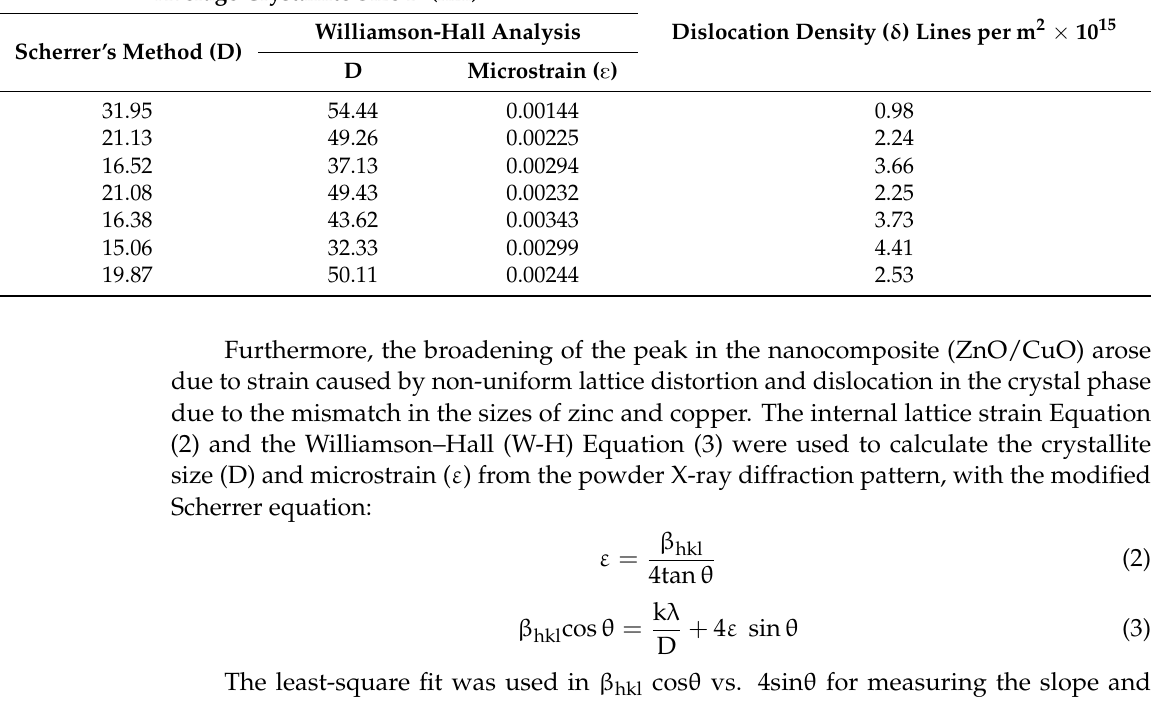
Table 1. Comparison of crystallite size, lattice strain, and dislocation density of ZnO, CuO, and ZnO/CuO nanoparticles.